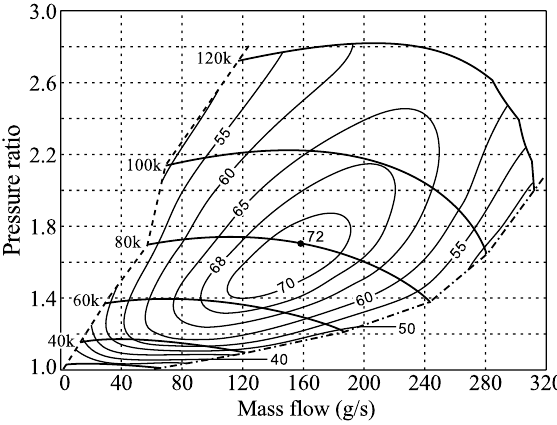
Figure 1. A typical compressor map for a passenger